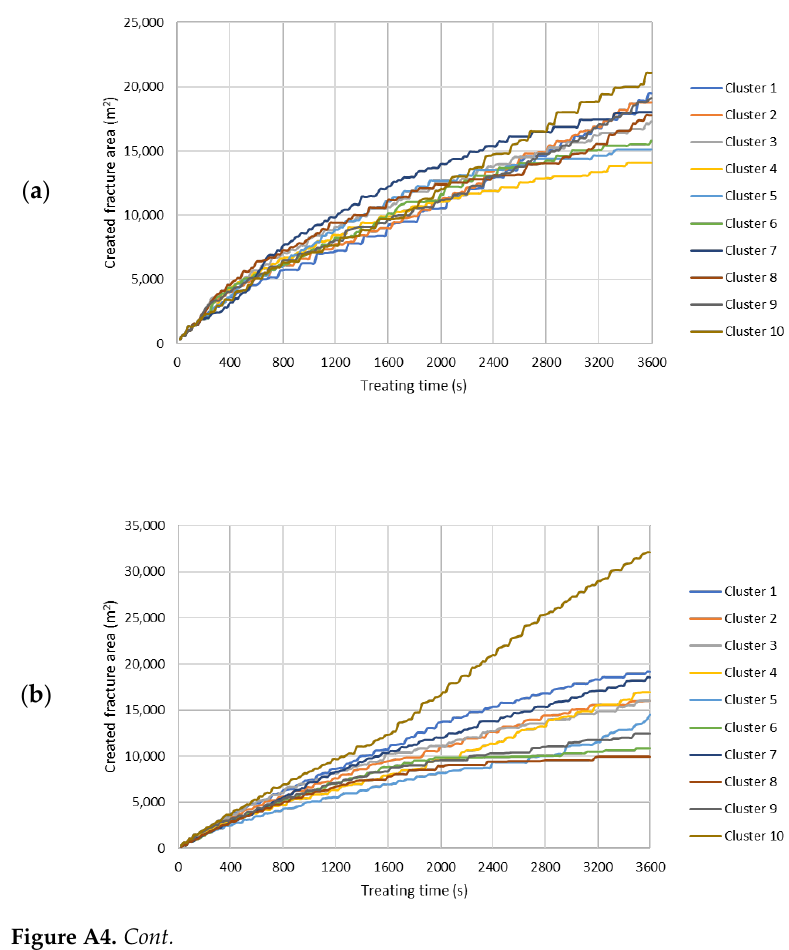
Figure A4. Created fracture surface area of each cluster during the hydraulic fracturing treatment. ( a ) Slick water case. ( b ) NG foam case. ( c ) Hybrid NG/NG foam case.